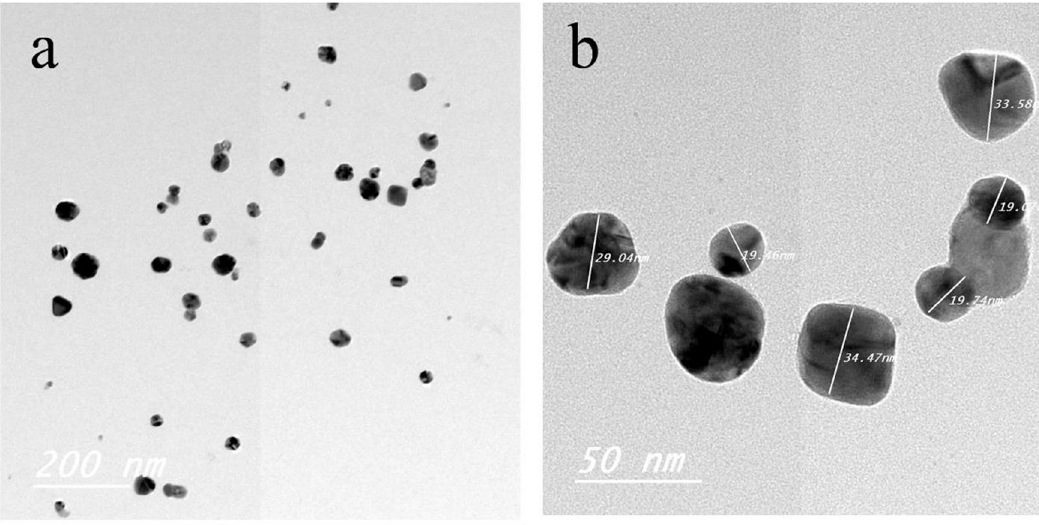
Figure 1. TEM photography of nano-silver particles (Ag NPs). The morphological shape ( a ) showed the fine spherical and elliptical particles of nano-silver besides the diameter of NPs ( b ) was ranged from 19.07- 34.47